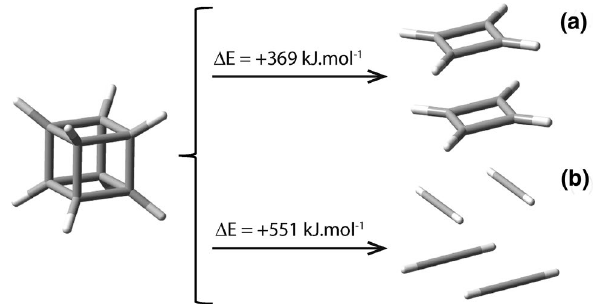
Figure 6. Pictorial representation of the dissociation reaction of nugget 8 into ( a ) two cyclobutadiene compounds, C 8 H 8 → 2C 4 H 4 , and ( b ) four ethyne molecules C 8 H 8 → 4C 2 H 2 . The values of ΔE shown are from ωB97XD/6-31G* calculations and are given in kJ mol −1 units because they refer to chemical reactions involving one mole of reactant only.